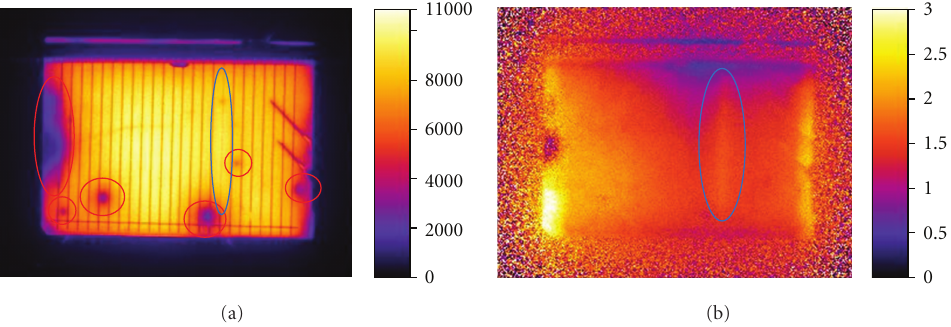
Figure 5: (a) Open-circuit PL image of a PERC cell fabricated using BA-LIP Ni and LIP Cu plating. The edges of the cell have been isolated with a laser. Red circles are shunt locations. Blue circle location of a peeled finger; (b) series resistance PL image of the same cell using a bias voltage of − 300 mV.